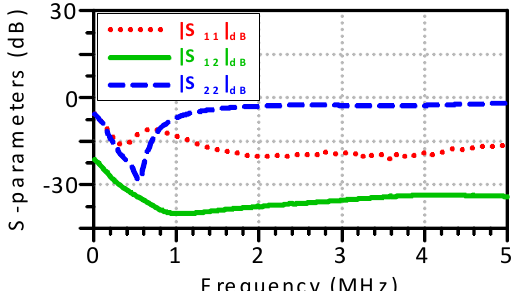
Figure 5: Isolation and return losses of the NGD device shown in Figure 2.